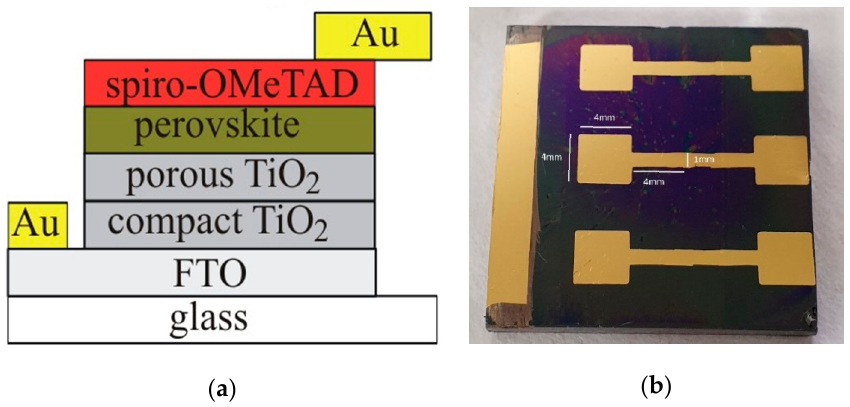
Figure 1. ( a ) Schematic cross section of the perovskite solar cell; ( b ) top view microphotograph of the perovskite solar cell.